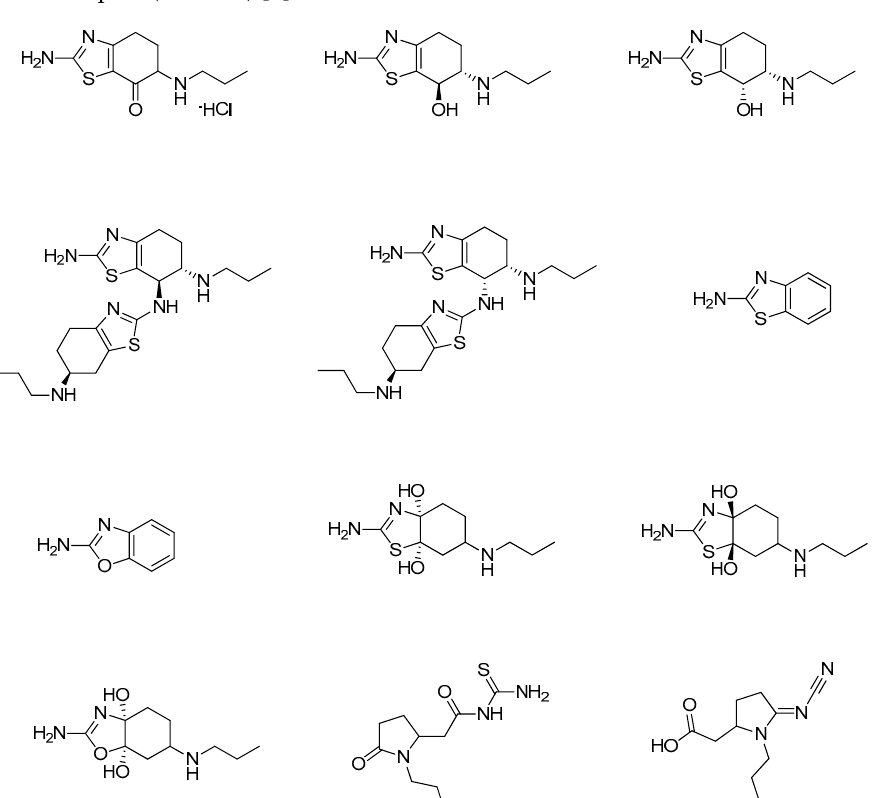
Figure 1. Chemical structure of pramipexole dihydrochloride monohydrate.